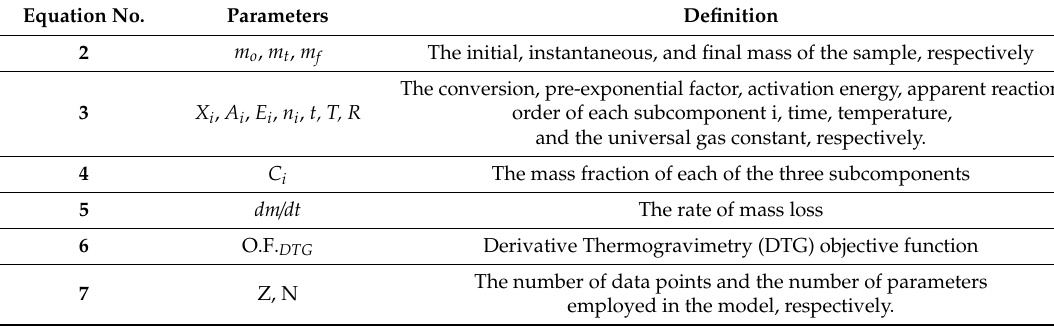
Table 1. Definition of the e ff ective parameters of the independent parallel reactions (IPR) model [34]. Equation